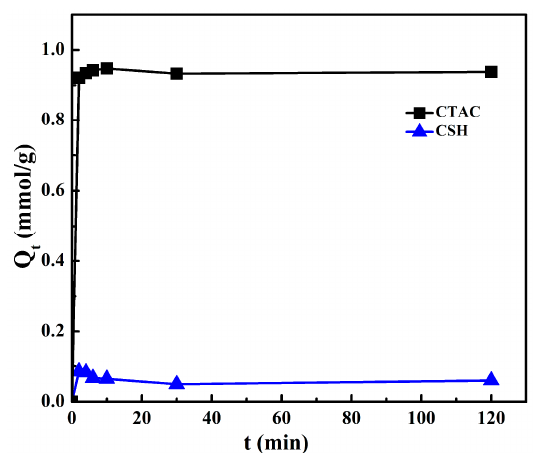
Figure 3. Effect of time on the adsorption amount ( Q t ) of modifiers.